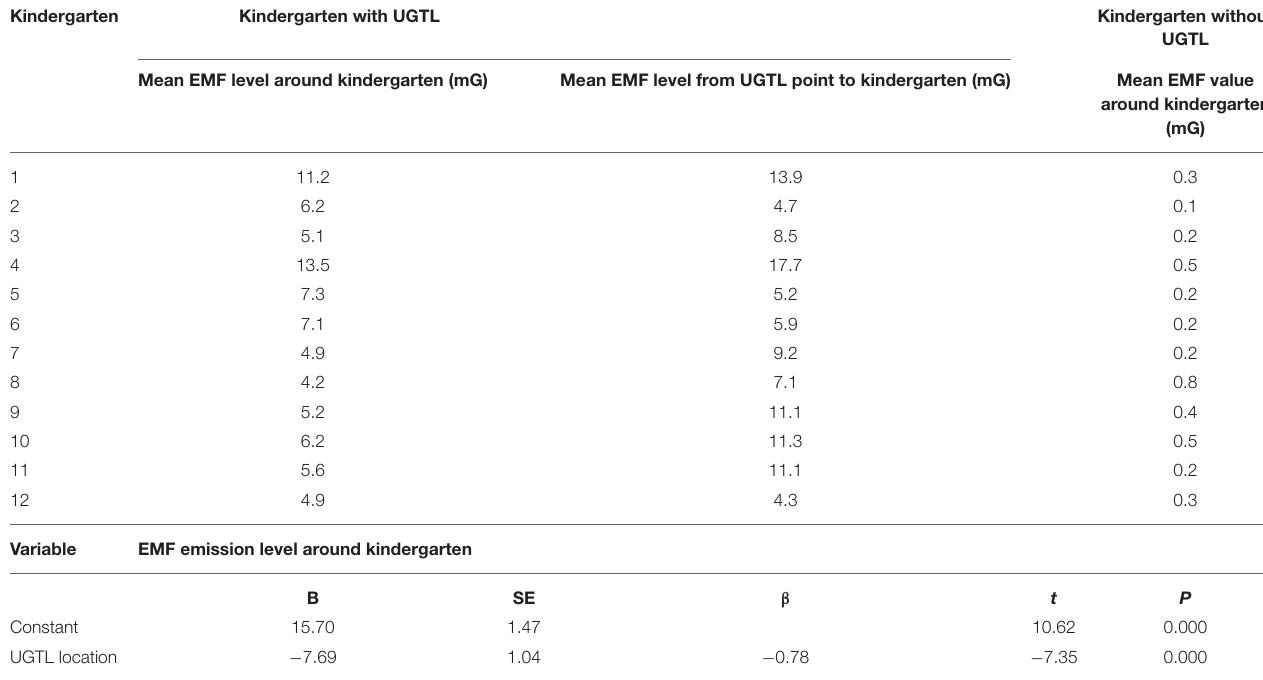
TABLE 1 | EMF emission level in selected kindergartens.